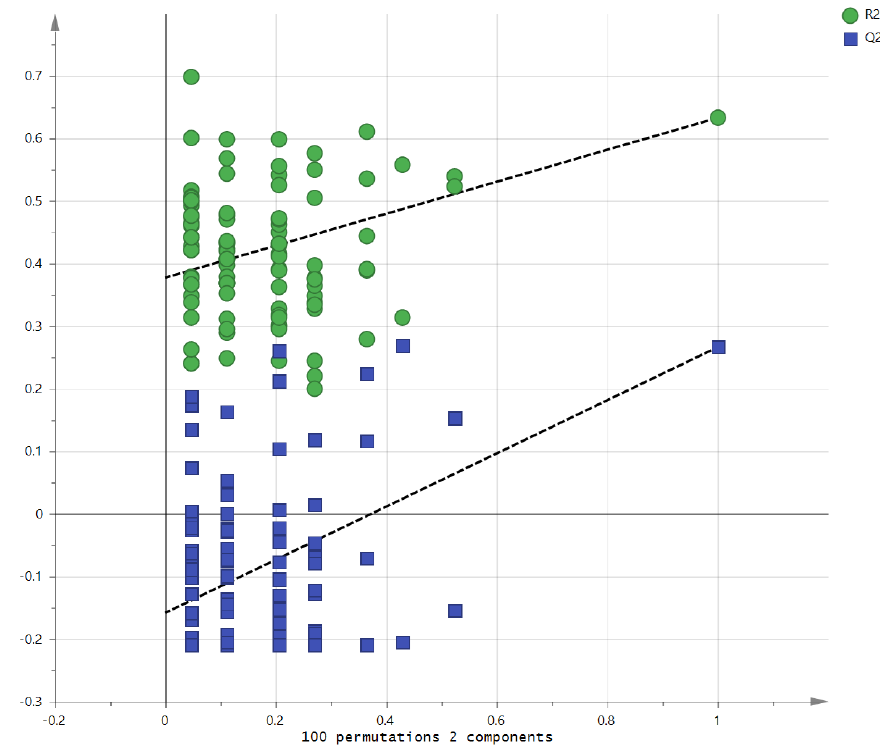
Diagnostics 2022 , 12 , x FOR PEER REVIEW Figure 3. Validation of the OPLS model using the 100-permutation test. Figure 3. Validation of the OPLS model using the 100-permutation test.